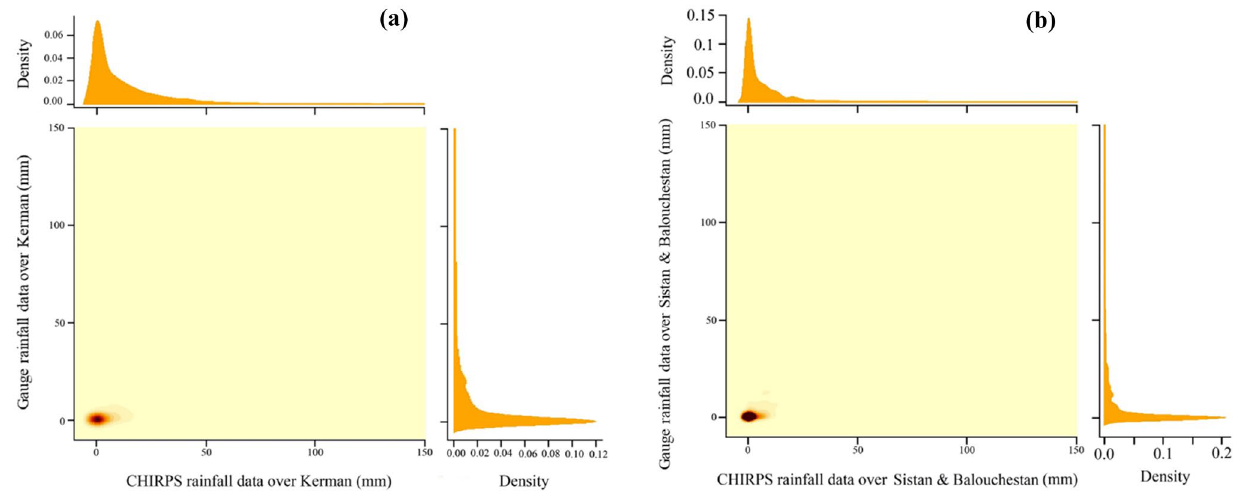
Fig. 5 Two-dimensional kernel density estimate plots for CHIRPS and rain gauge monthly precipitation over a Kerman and b Sistan and Balouchestan